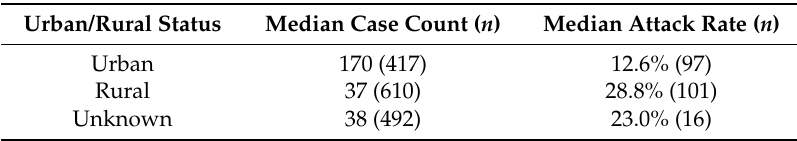
Table 5. Outbreak health data by urban/rural status.